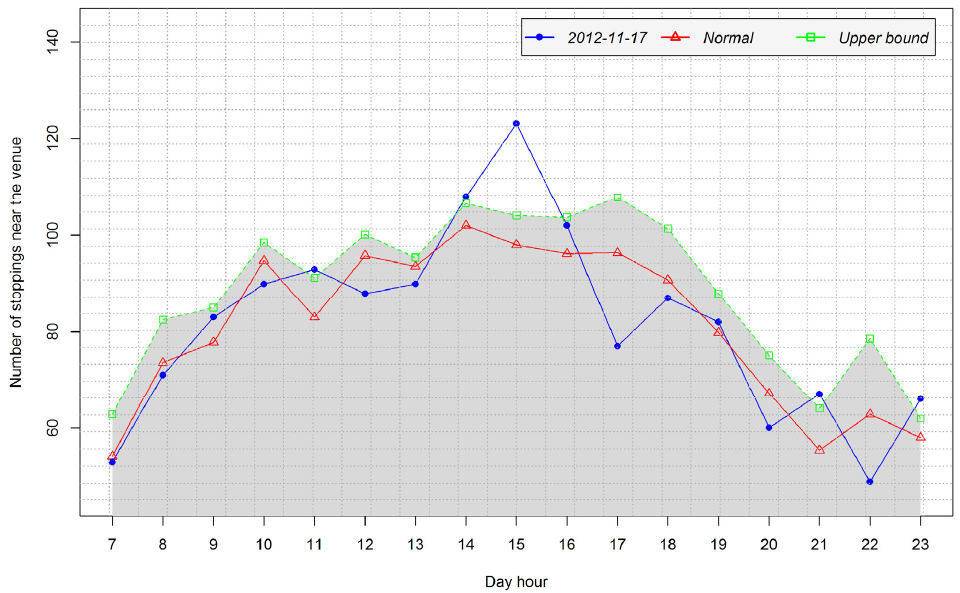
Figure 12. The variation of the number of bus stoppings at the National Concert hall on a day with an event.